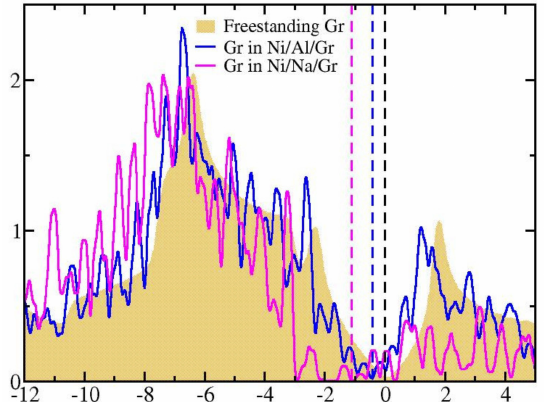
Figure 4. The shaded region in yellow is the DOS plot for pristine free-standing graphene, blue and pink lines denote graphene in Ni(111)/Al/Gr and Ni(111)/Na/Gr, respectively. The Dirac point shift was found by the lowest occupied density of states below the Fermi level (dotted vertical